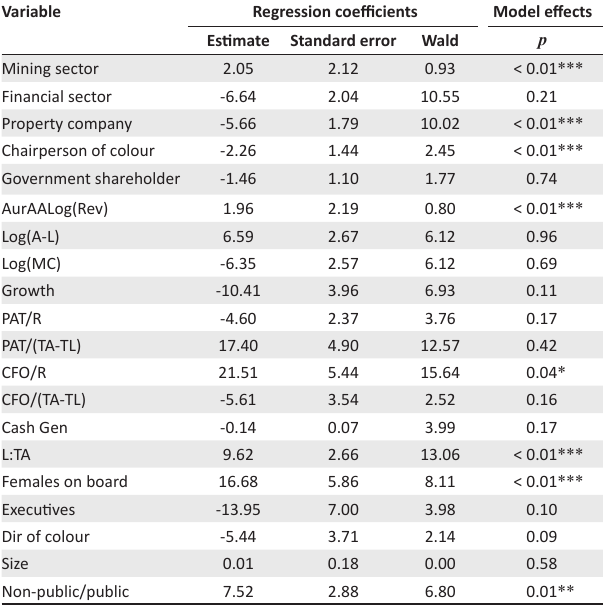
TABLE 5: Results of the generalised estimation